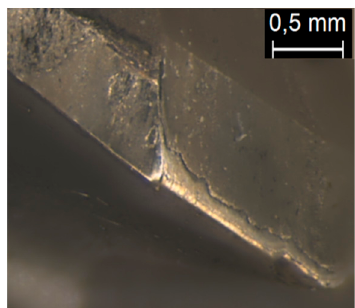
Figure 5. Detailed view of the relief surface of the tool with the lower lubrication level, after 40 holes.